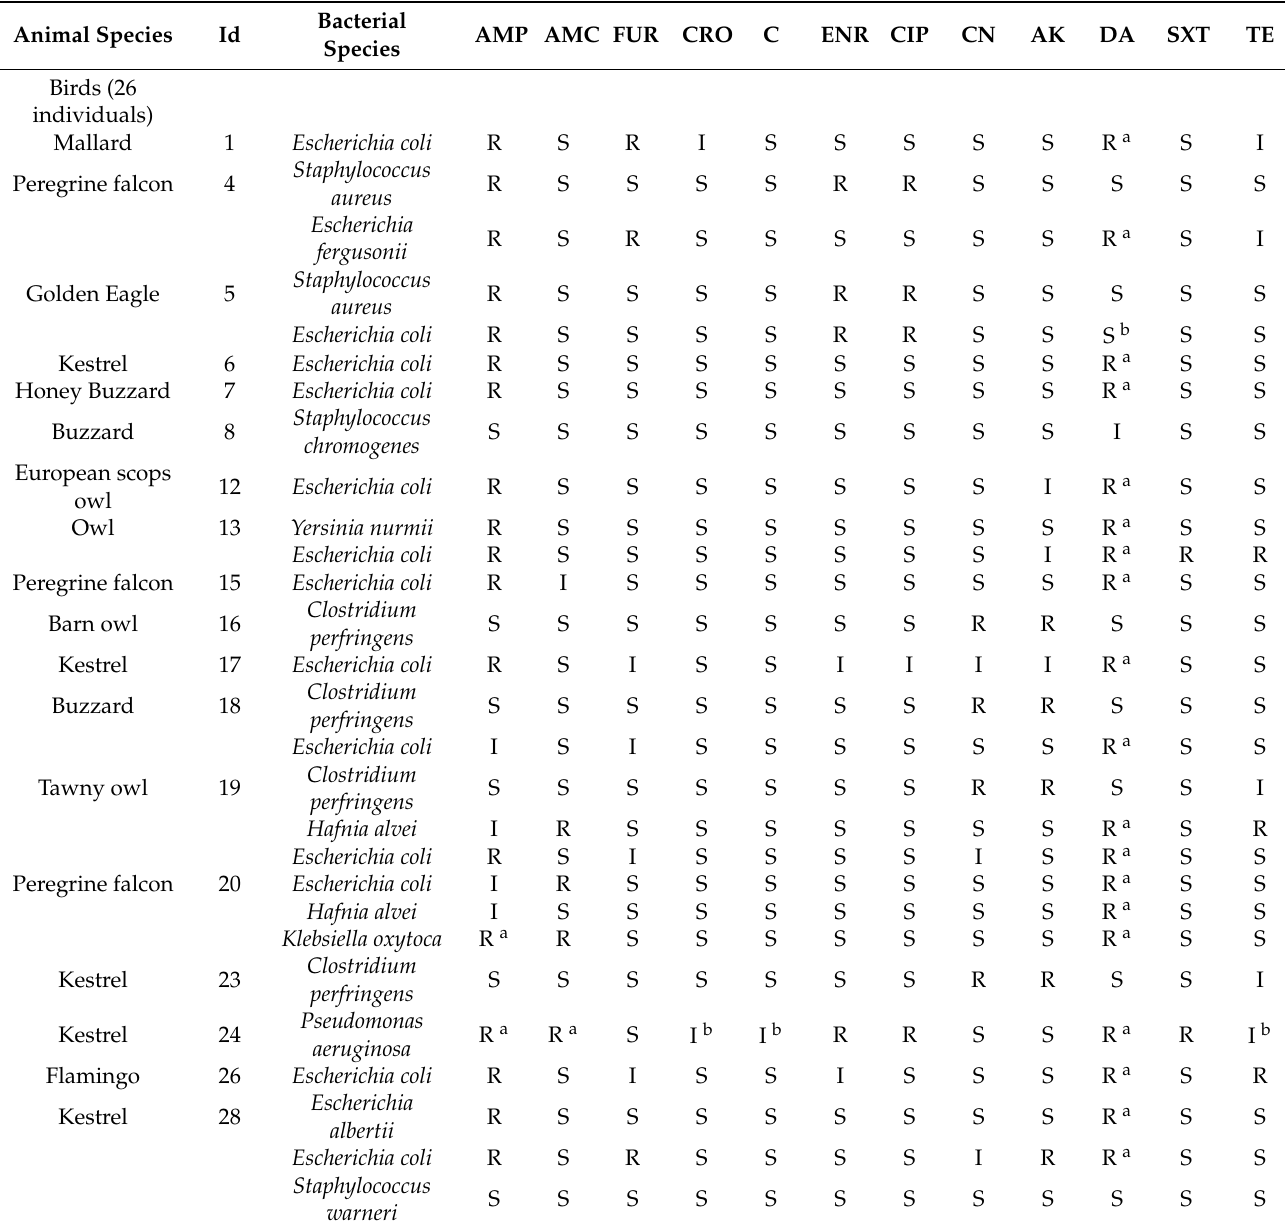
Table 4. The antibiotic susceptibility results ( n =